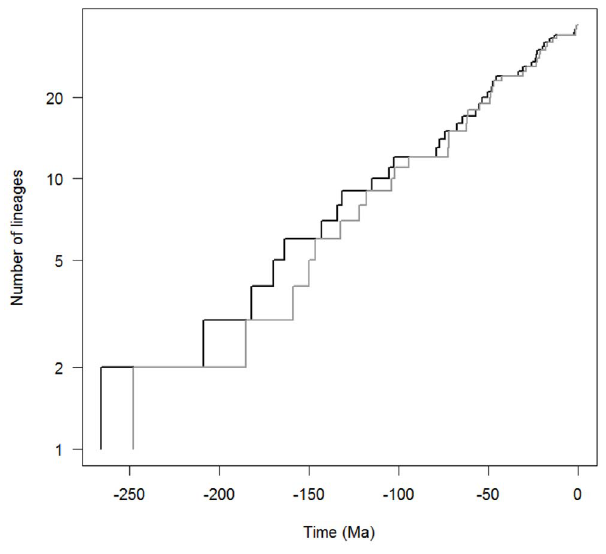
Figure 3. LTT plots for the genus Aeromonas . Log-lineage- through-time (LTT) plot for the genus Aeromonas based on Bayes (dark line) and MLA (grey line) approaches.